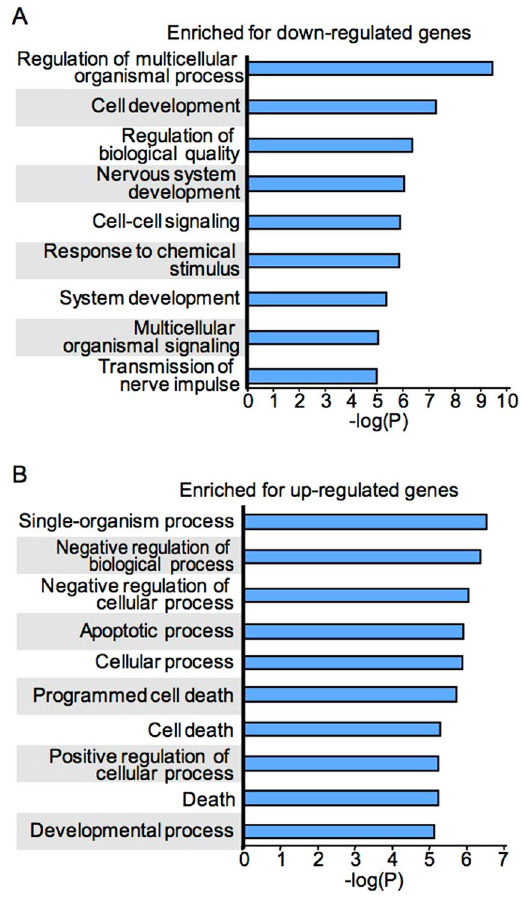
Figure 1. Gene ontology enrichment among genes affected by Bmi1 overexpression in aNSCs. Categories enriched for genes down-regulated ( A ) or up-regulated ( B ) at least two-fold upon Bmi1 overexpression in aNSCs are indicated along with − log of the corrected p-value for each category. All categories having corrected p-value < 10 − 5 are shown except for unannotated genes, which were enriched among down-regulated genes.